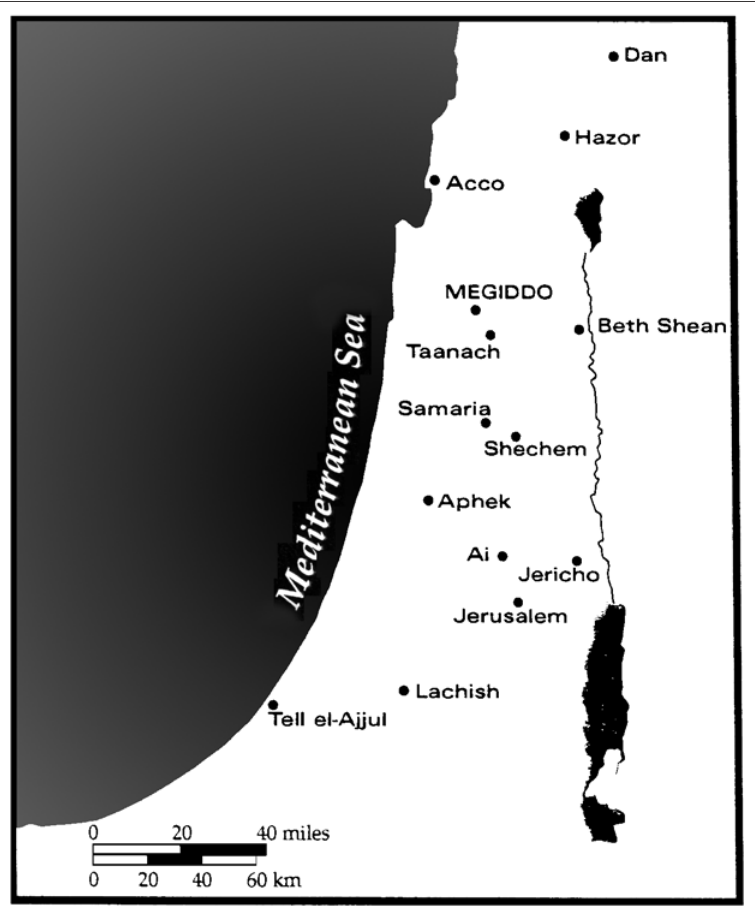
Figure 1: Syria-Palestine in the Bronze and Early Iron Ages (Second and early fi rst millennia